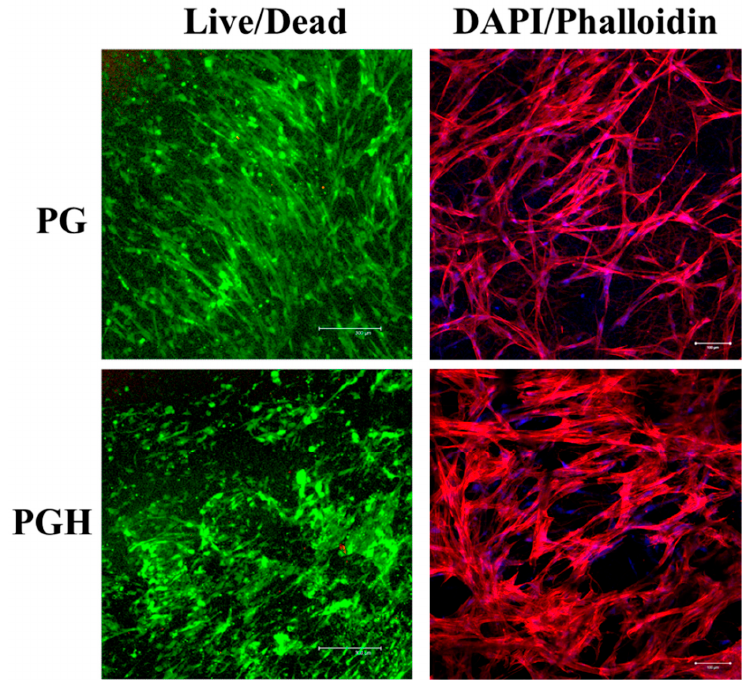
Figure 5. The confocal microcopy images after culture ASCs in PG and PGH fibrous membrane scaffolds (FMS) for 7 days. The merged images from Live/Dead staining show live cells in green and dead cells in red (bar = 300 μ m). The merged images from DAPI/phalloidin staining show actin cytoskeleton in red and cell nuclei in blue (bar = 100 μ m). Biomedicines 2022 , 10 , x FOR PEER REVIEW To study whether HA can stimulate the expression of genes important for skin re- generation, relative mRNA expressions of VEGF, TGF- β 1, TGF- β 3, and KGF were de- termined by qRT-PCR on day 7. Compared to cells in PG, ASCs in PGH show signifi- cantly up-regulated gene expression for all tested genes (Figure 6).